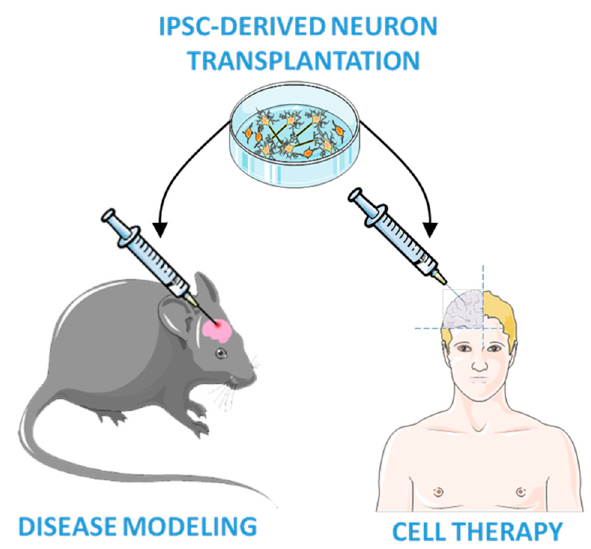
Figure 3. iPSC-based transplantation technologies. iPSC-derived neuroprecursors are transplanted into an adult mouse brain to study neuronal differentiation for epilepsy modeling and for future cell therapies in humans.